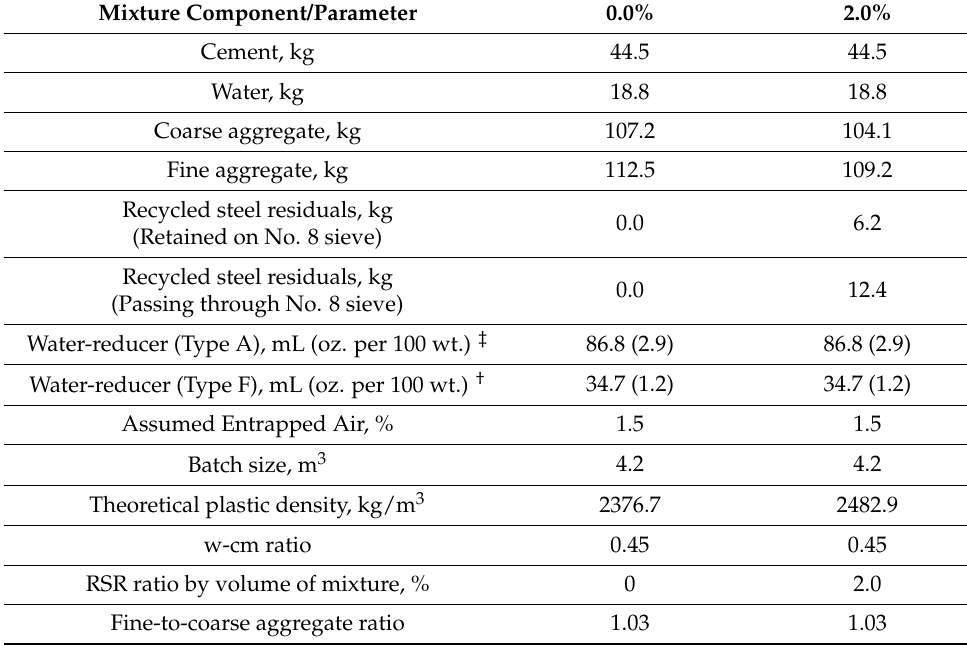
Table 1. Concrete Mixtures for Specimen Creation.